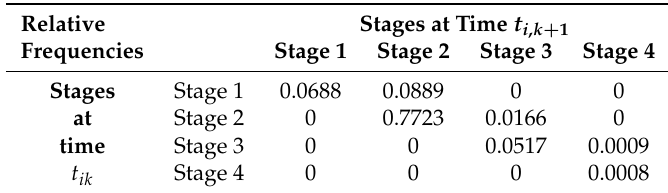
Table 8. Aneurysm data: relative frequencies of transitions between stages of aortic diameter with